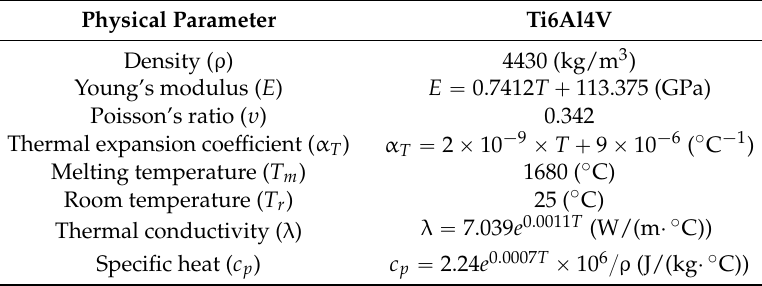
Table 1. Mechanical properties of the Ti6Al4V phase